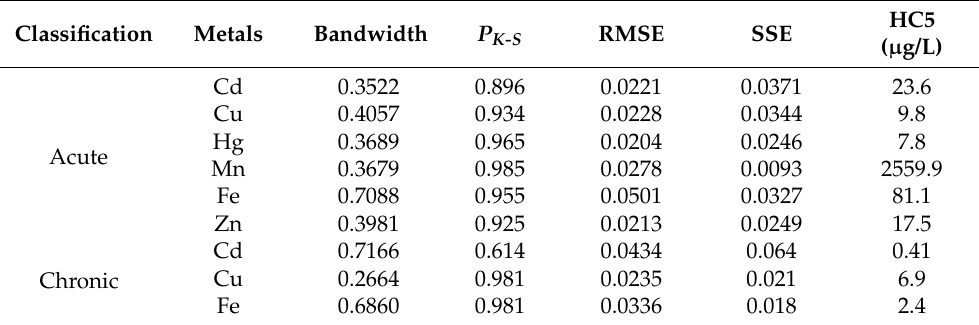
Table 1. Overview of the acute and chronic NPKDE-SSDs of transition metals in South Asia. Pa- rameters including the distribution parameter (bandwidth), goodness-of-fit evaluation results of the model ( p -value of Kolmogorov–Smirnov (K-S) test, root mean square error (RMSE), and error sum of squares (SSE)), and HC5